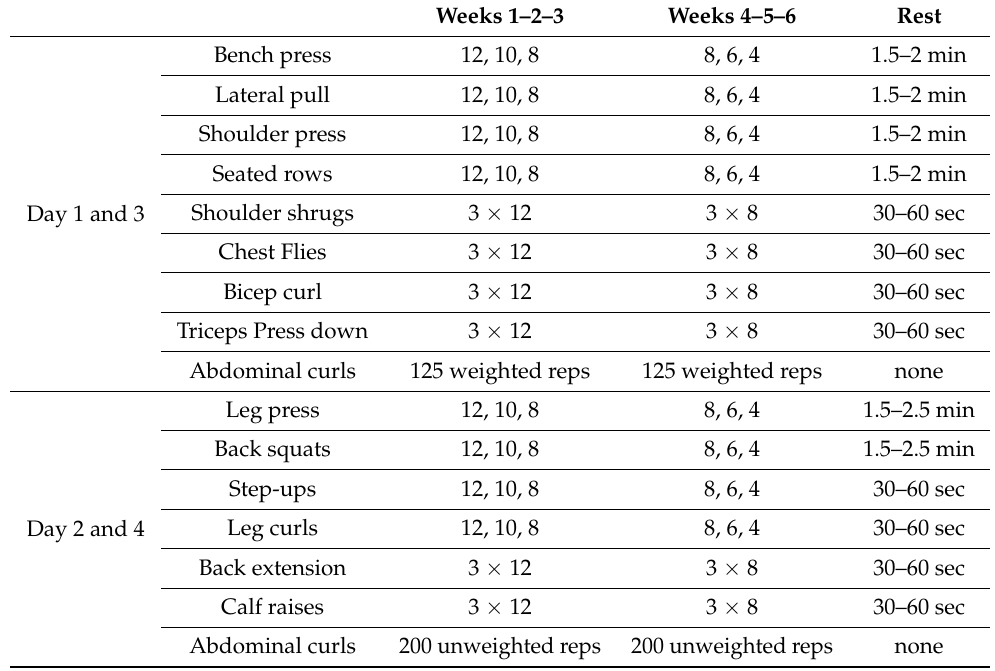
Table 2. Resistance training